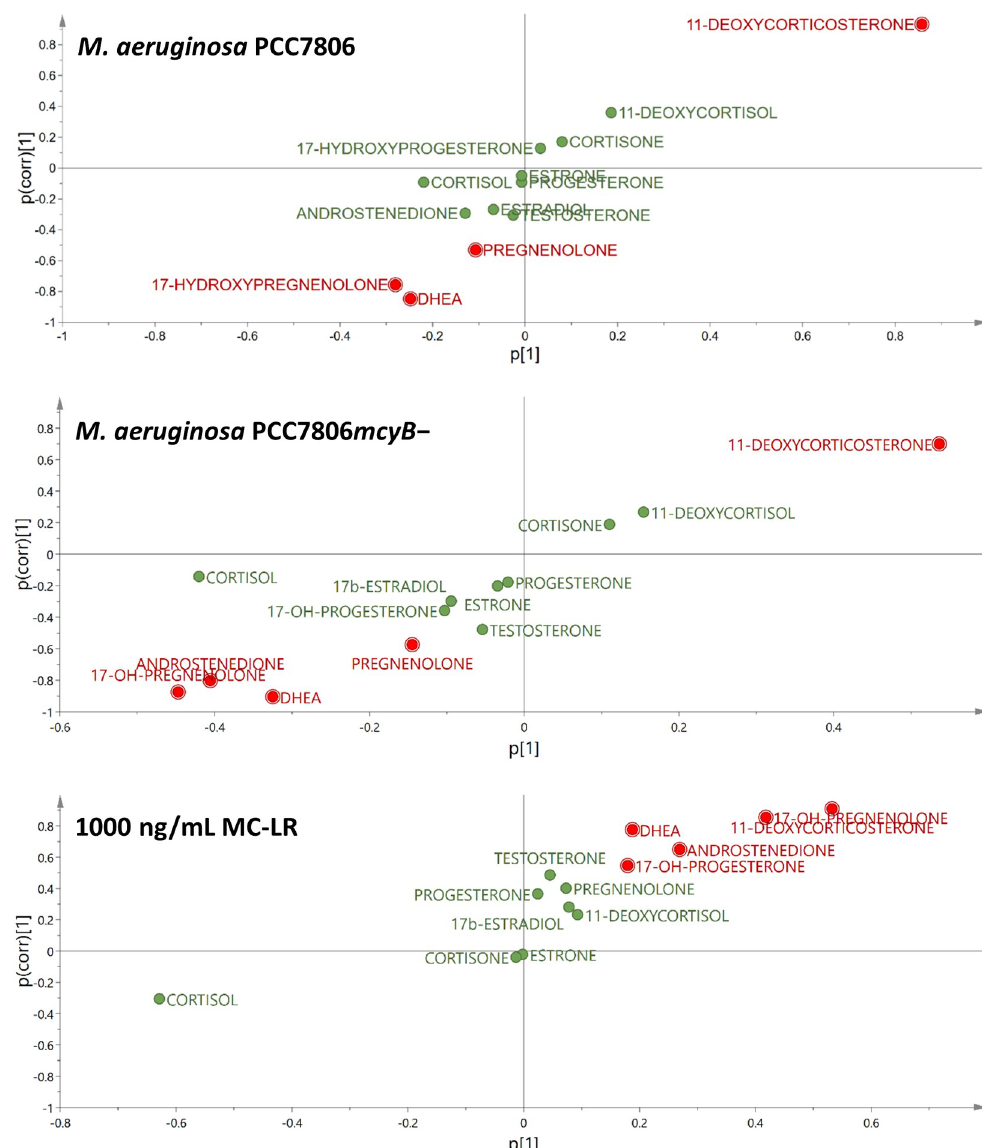
Fig 4. S-plots from valid orthogonal partial least squares discriminant analysis (OPLS-DA) models. S-plots from two- class OPLS-DA models including observations for positive (1.5 μ M forskolin) control versus either the wild type of M . aeruginosa PCC7806 (upper plot), its MC-deficient mutant PCC7806 mcyB− (middle plot), or 1000 ng/mL MC-LR (lower plot). The plots show that 11-deoxycorticosterone was upregulated for all exposures. Dehydroepiandosterone (DHEA) and 17-hydroxypregnenolone were downregulated in exposures for both M . aeruginosa PCC7806 strains but upregulated following MC-LR exposure. Related hormones, i.e. androstenedione and pregnenolone followed the same pattern but were not among the main discriminating variables in all three models. Cortisol was not included in the selection of significant variables as it was the major contributing factor to orthogonal variation (oVIP =